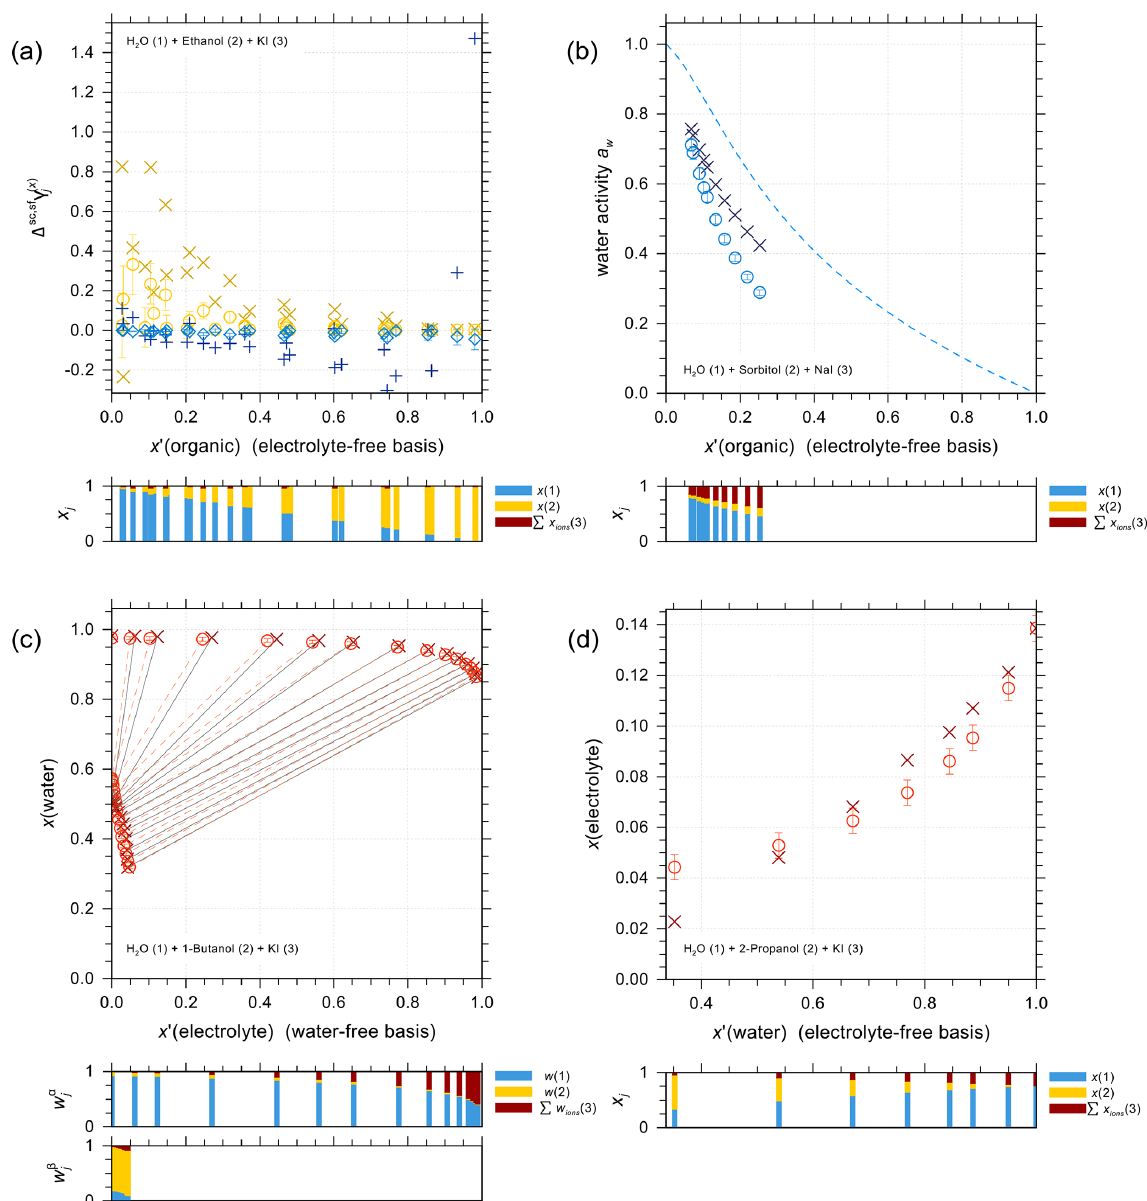
Figure 5. Different types of experimental data ( × , + ) and AIOMFAC predictions ( ◦ , (cid:5) ) for water + alcohol + iodide salt systems with model sensitivity indicated by error bars. (a) Isobaric VLE data of water (1) + ethanol (2) + KI (3) at 351–366K; experiments by Chen and Zhang (2003). (b) Water activity of water (1) + sorbitol (2) + NaI (3) at 288K; experimental data (this study) for 1 : 1 mass ratio of sorbitol : NaI. (c) LLE of water (1) + 1-butanol (2) + KI (3) at 298K; experiments by Al-Sahhaf and Kapetanovic (1997). (d) SLE